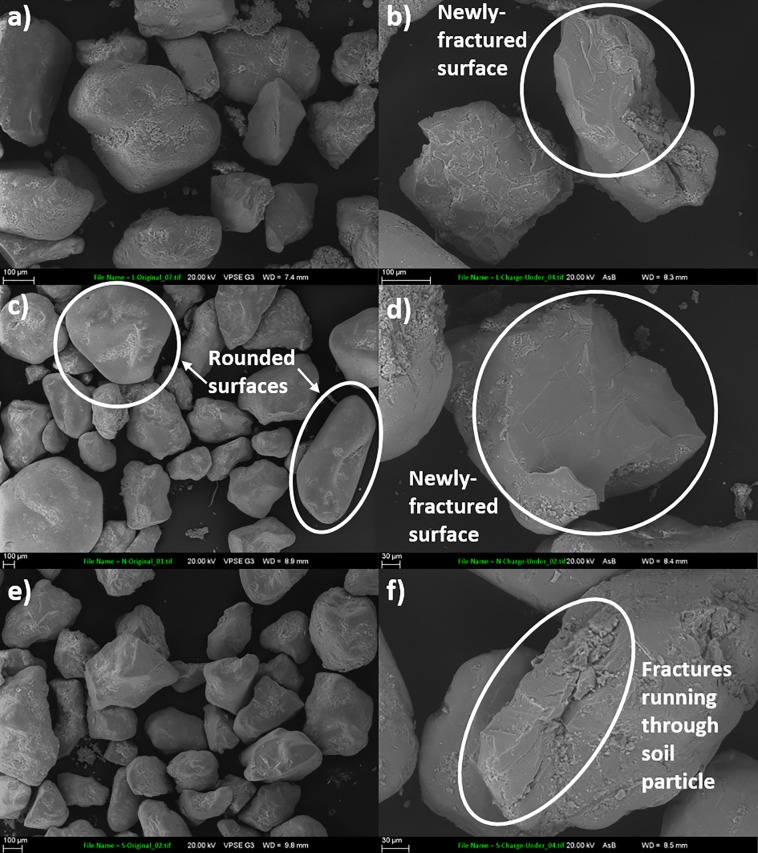
SEM images of a) pre-blast landscape soil, b) post-blast landscape soil, c) pre-blast native soil, d) post-blast native soil, e) pre-blast Spearwood soil and f) post-blast Spearwood soil. In each of the post-blast soils illustrated in this figure, the explosive was detonated in contact with the soils. Newly-cleaved planes and fractures are visible within each post-blast soil. Note that the post-blast soils are displayed at a higher magnification than the pre-blast soils, to more clearly illustrate the detonation-induced damage to the soils. Source: Evelyne Delbos, James Hutton Institute.